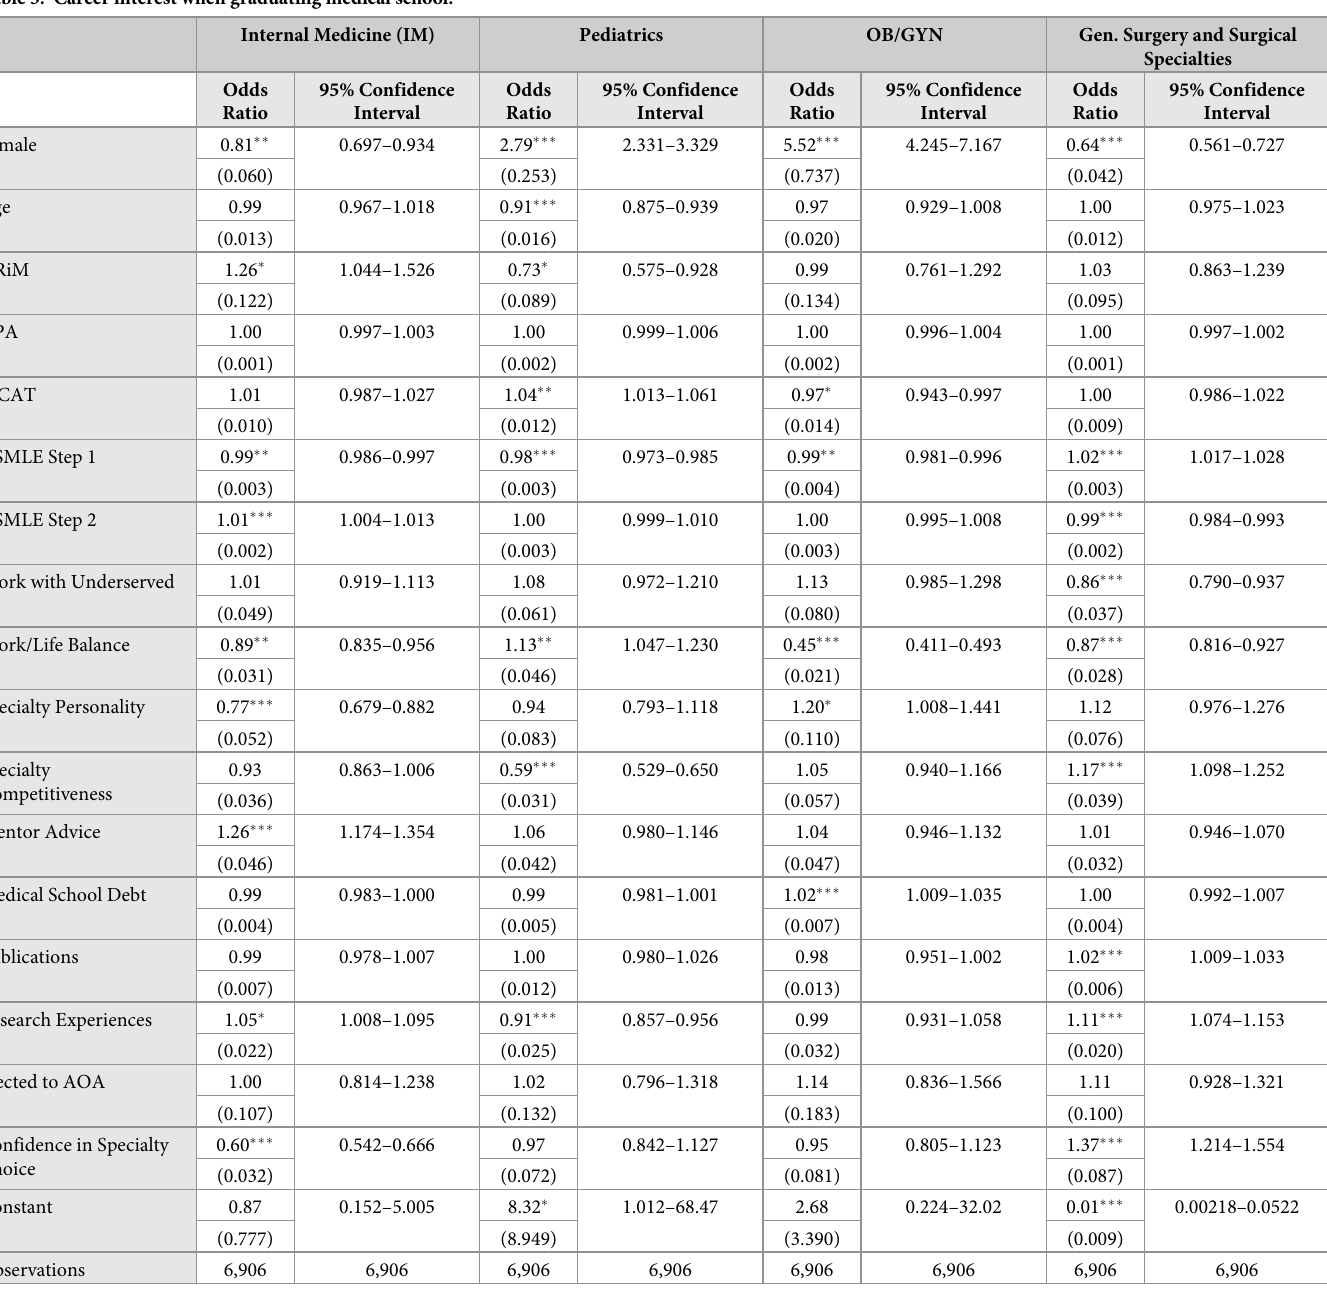
Table 3. Career interest when graduating medical